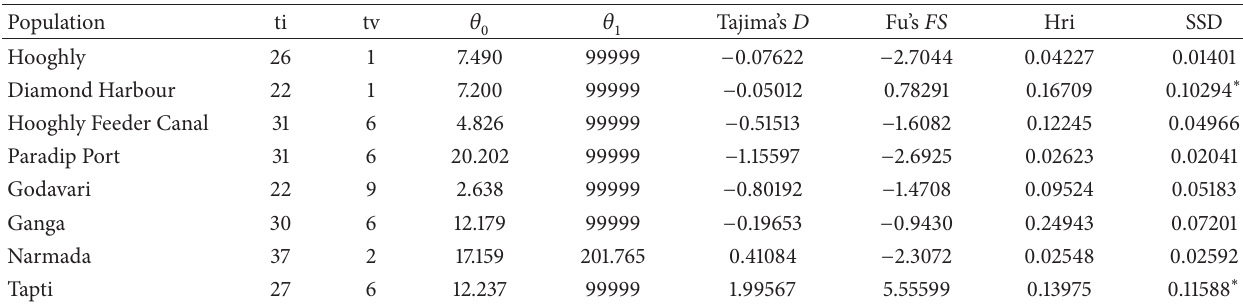
Table 5: Genetic diversity indices and demographic parameters of T. ilisha